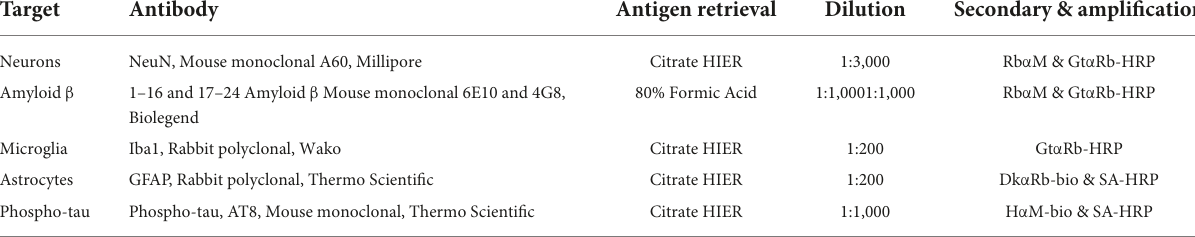
TABLE 2 Primary and amplification antibodies used for